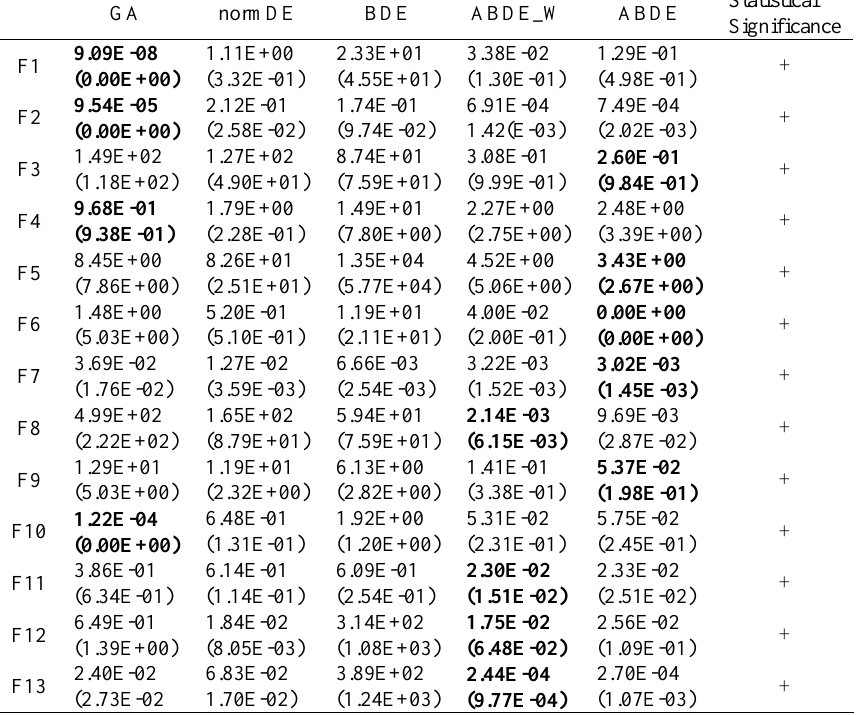
Table 1. Mean best values and its standard deviation at